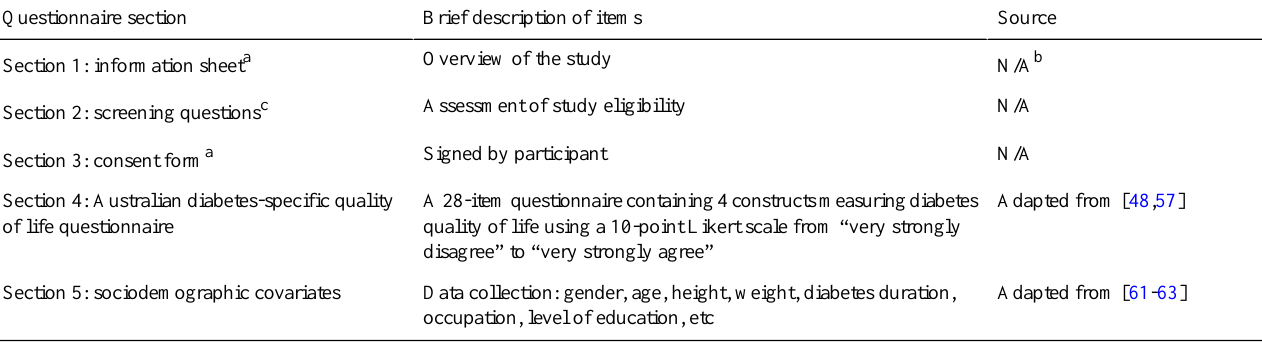
Table 2. Study phase 2a–initial validation: online Australian diabetes-specific quality of life questionnaire completed by adults with type 1 diabetes mellitus (N=364).